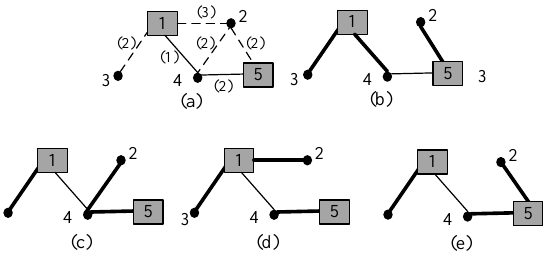
Figure 5. Examples of the proposed topology generation algorithm.